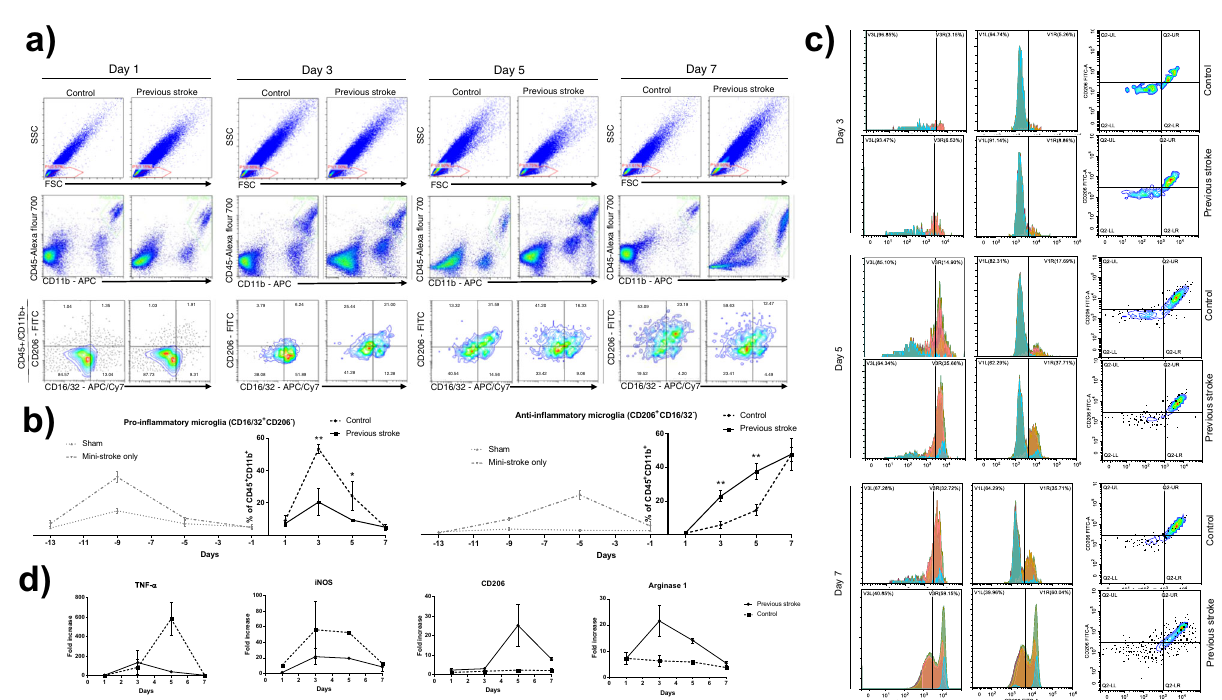
Fig. 4 Flow cytometry and mRNA analysis of in vivo peri-hematomal tissue. a Leukocytes were fi rst gated from the FSC/SSC plot. Microglia were identi fi ed among leukocytes as CD45 + CD11b + cells. Signi fi cant elevation of CD16/32 + CD206 − cells (M1 microglia) was seen in both groups on day 3, but the previous stroke group had a concomitant elevation in CD206 + CD16/32 − cells, (M2 microglia) which the control group did not have. On day 5, both groups were presenting CD16/32 and CD206 markers, yet the percentage of CD206 + CD16/32 − cells continued to be signi fi cantly higher in the previous stroke group, whereas CD16/32 + CD206 − cells continued to be lower. b Left graph displaying the calculated percentage of CD45 + CD11b + , CD16/ 32 + CD206 − cells at each time point, representing the M1 microglia. Right graph displaying the calculated percentage of CD45 + CD11b + , CD206 + CD16/ 32 − cells at each time point, representing M2 microglia ( n = 7 on each day). Both M1 and M2 levels returned to baseline levels in the sham and mini-stroke only groups before the major hemorrhagic stroke took place on day 0 (Gray lines; n = 4 on each day). Error bars indicate SEM. * p < 0.05 ** p < 0.01. c Simultaneous expression of CD163 and CD206 revealed a near-identical percentage of double-positive cells each day, further verifying the M2 polarization pro fi le. d qPCR analysis of in vivo samples. Mice were sacri fi ced on days 1, 3, 5, and 7. The right peri-hematomal region was obtained for mRNA extraction and analysis. TNF- α was elevated earlier in the previous stroke group but reached a much higher peak in the control group on day 5. iNOS